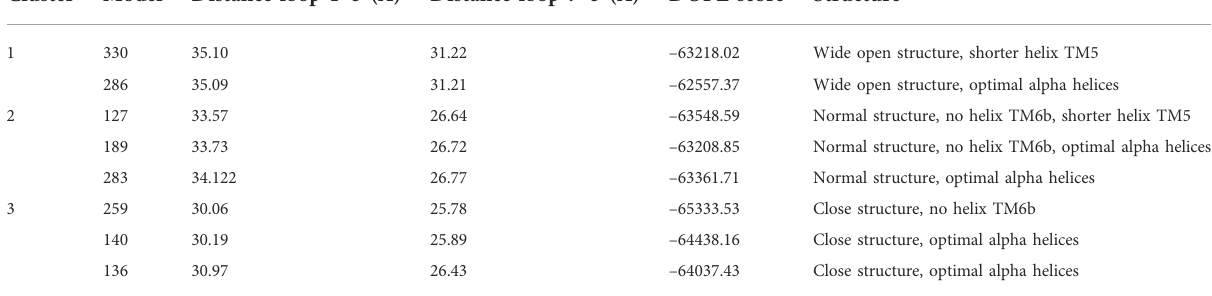
TABLE 2 Description of different selected models.